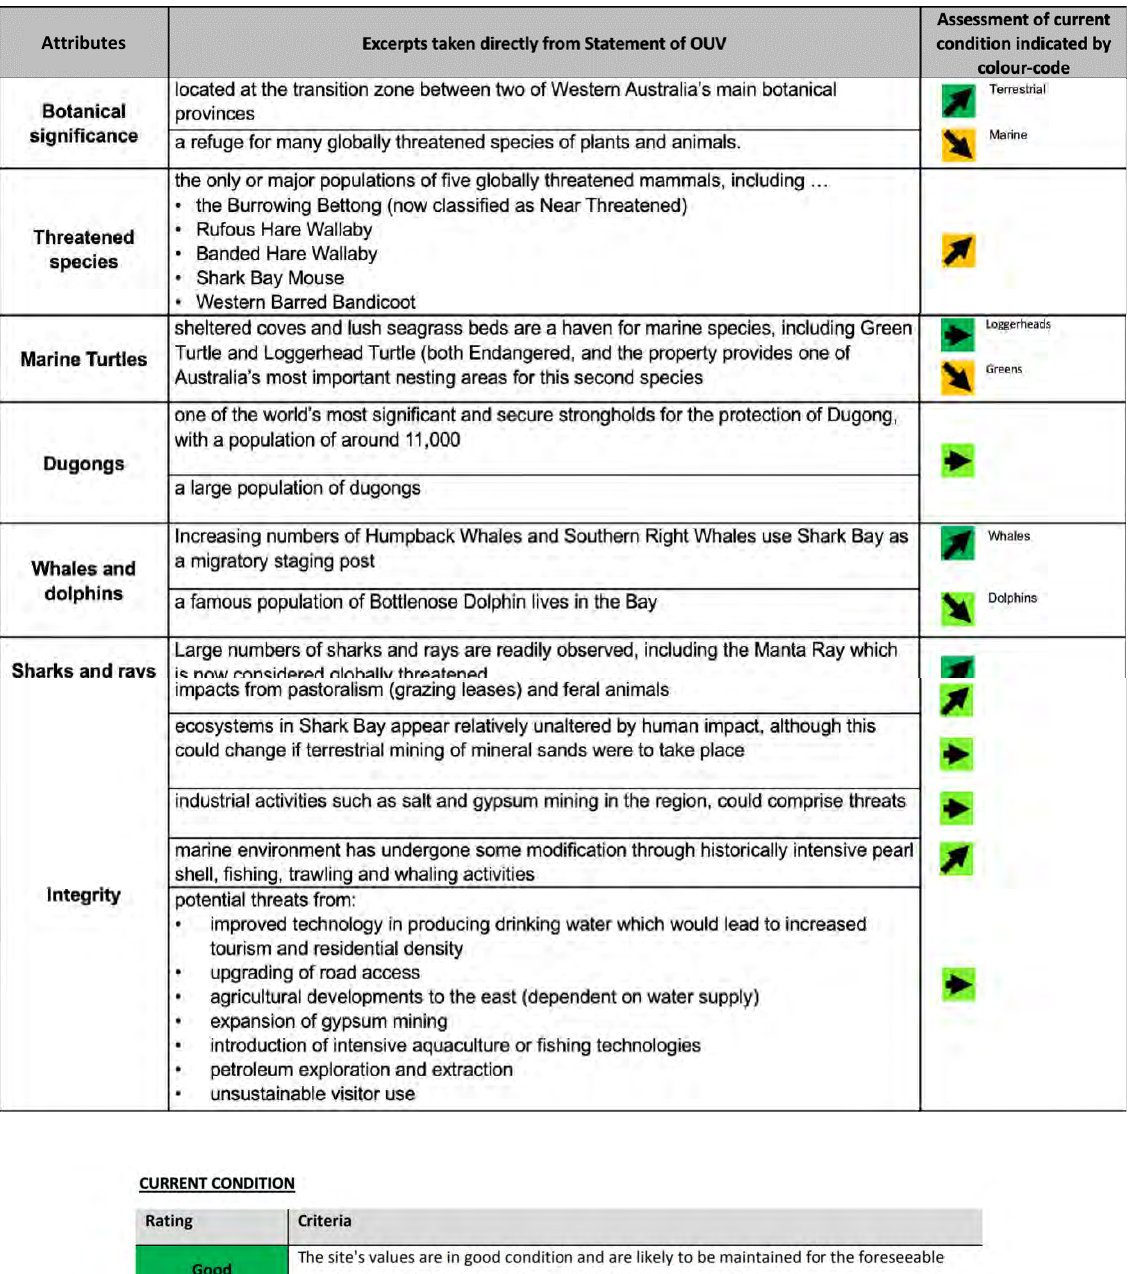
Table 2.1 (cont.) Attributes for Shark Bay, Western Australia derived from the Statement of Outstanding Universal Value (OUV), together with the assessed current condition and trend since